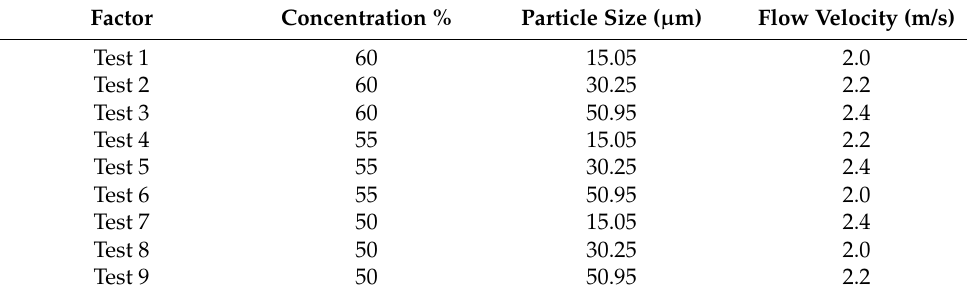
Table 4. Experimental